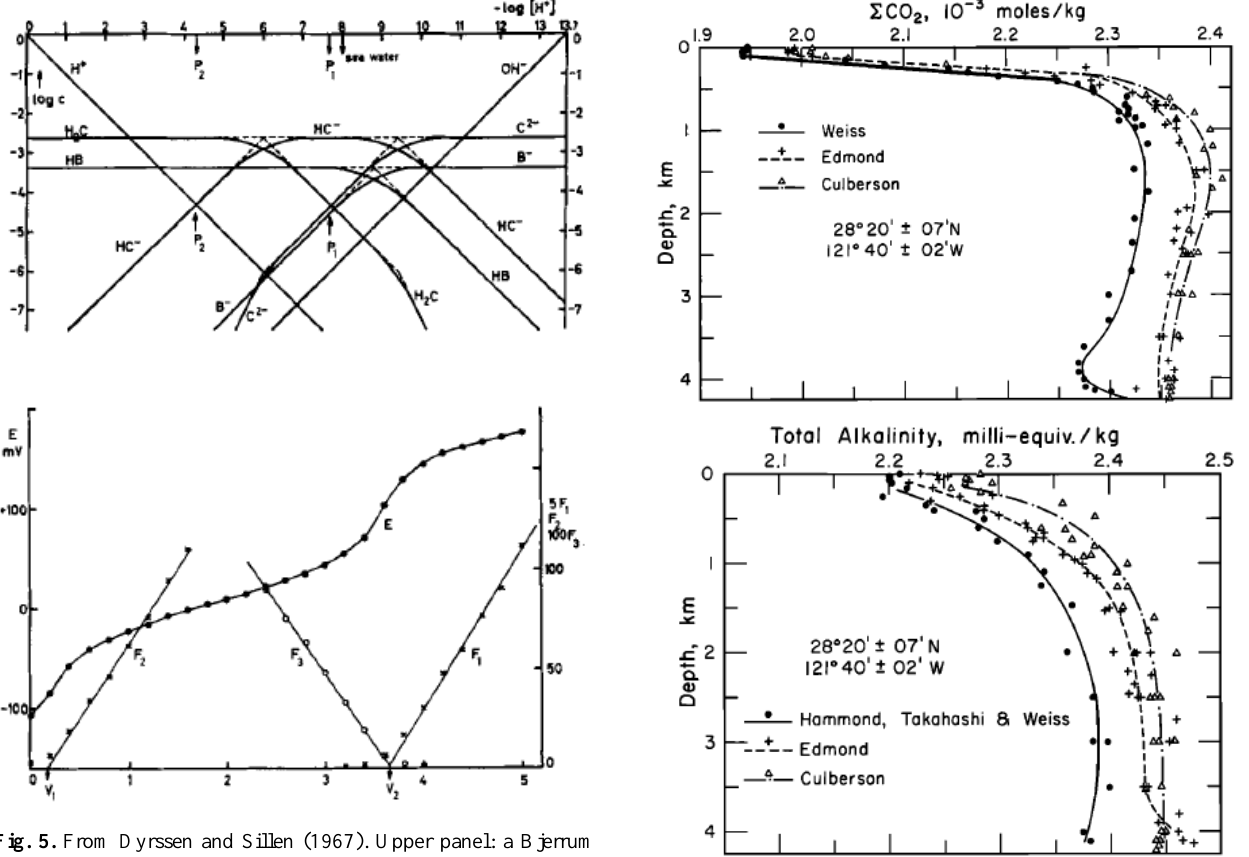
Fig. 5. From Dyrssen and Sillen (1967). Upper panel: a Bjerrum Figure 5. From Dyrssen and Sillen (1967). Upper panel: A Bjerrum chemical chemical equilibrium plot of the major seawater species involved in Figure 6. From Takahashi et al. (1970). Results of various laboratory teams on protonation as acid is progressively added to seawater in a titration. equilibrium plot of the major sea water species involved in protonation as acid is Fig. 6. From Takahashi et al. (1970). Results of various laboratory (upper panel) and Total Alkalinity (lower measurements of sea water Total CO 2 Lower panel: the recommended “gran plot” treatment of the titra- teams on measurements of seawater total CO 2 (upper panel) and progressively added to sea water in a titration. Lower panel: The recommended panel) at the 1969 Geosecs test station offshore San Diego, California. The tion data so as to provide linear functions for determination of the total alkalinity (lower panel) at the 1969 Geosecs test station off- comparison if of results obtained by gas chromatography (solid circles), TCO “Gran Plot” treatment of the titration data so as to provide linear functions for 2 equivalence points, and a measure of both alkalinity and total CO 2 . shore San Diego, California. The t CO 2 comparison is of results ob- titration (+ marks) and a combination of pH and alkalinity ( Δ sign). The This procedure and its descendants were used thousands of times determination of the equivalence points, and a measure of both alkalinity and tained by gas chromatography (solid circles), titration ( + marks) (over 70 micromoles per kg) were discrepancies of between 3 and 5% in TCO during the Geosecs global survey in the 1970s. 2 and a combination of pH and alkalinity ( 1 sign). The discrepancies . This procedure and its descendants was used thousands of time total CO cause for concern. Data obtained today are typically better by about a factor of 2 of between 3 and 5% in t CO 2 (over 70 micromoles per kg) were during the Geosecs global survey in the 1970s. 30. cause for concern. Data obtained today are typically better by about a factor of